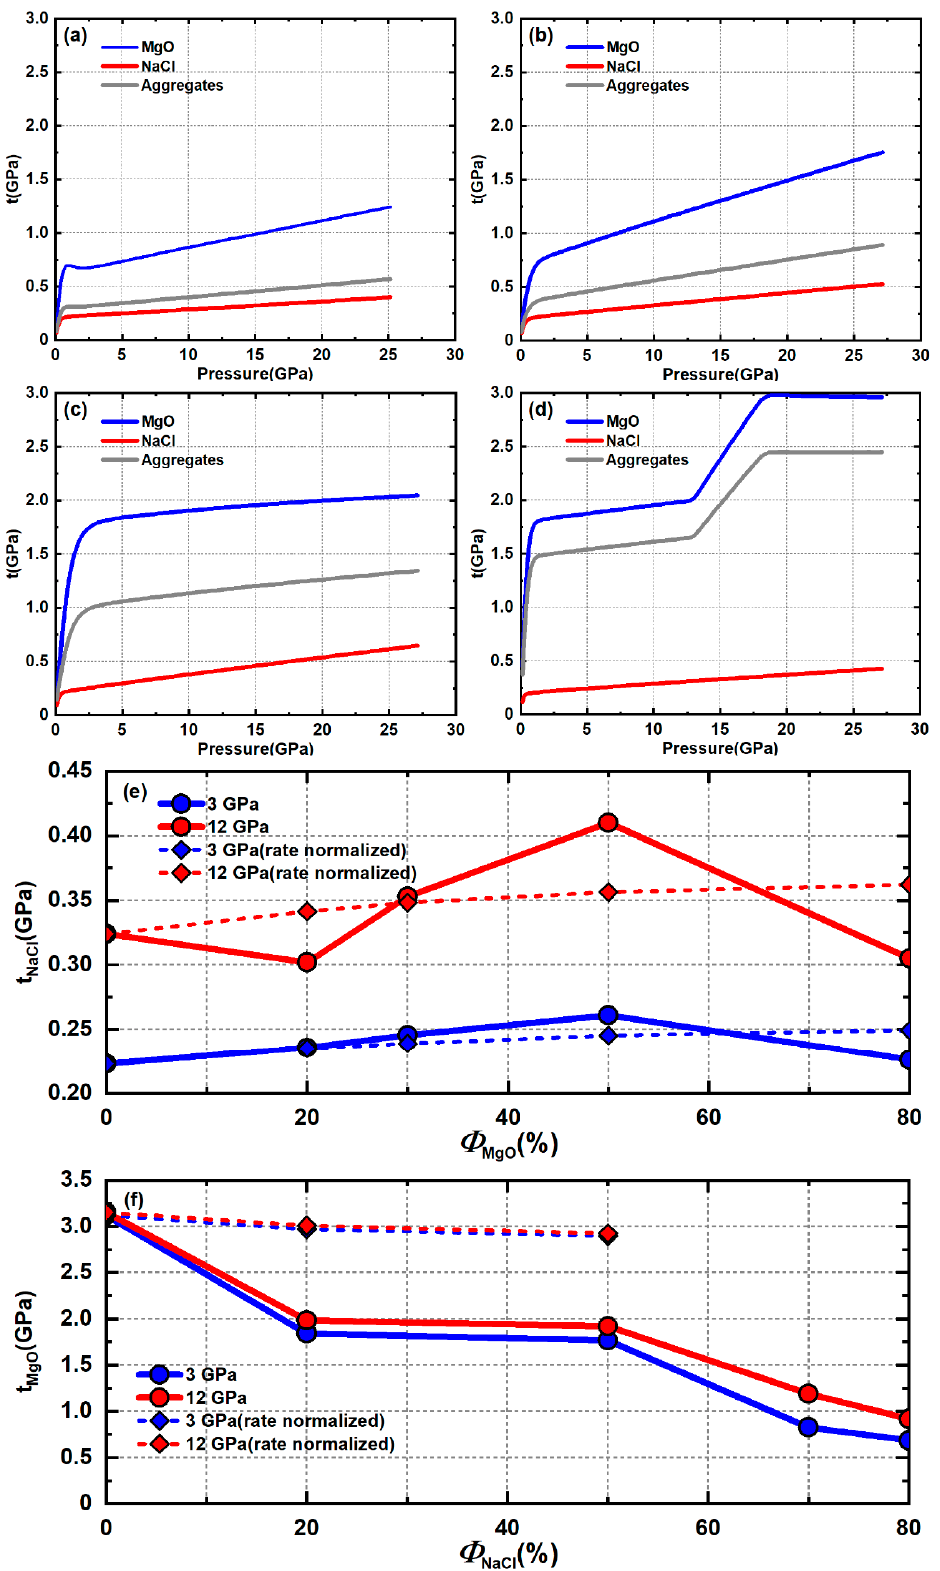
Figure 16. Stress of the aggregates, NaCl, and MgO under varying phase proportions: ( a ) 20% MgO + 80% NaCl; ( b ) 30% MgO + 70% NaCl; ( c ) 50% MgO + 50% NaCl; ( d ) 80% MgO + 20% NaCl; stress of individual phase under varying phase proportions: ( e ) NaCl; ( f )